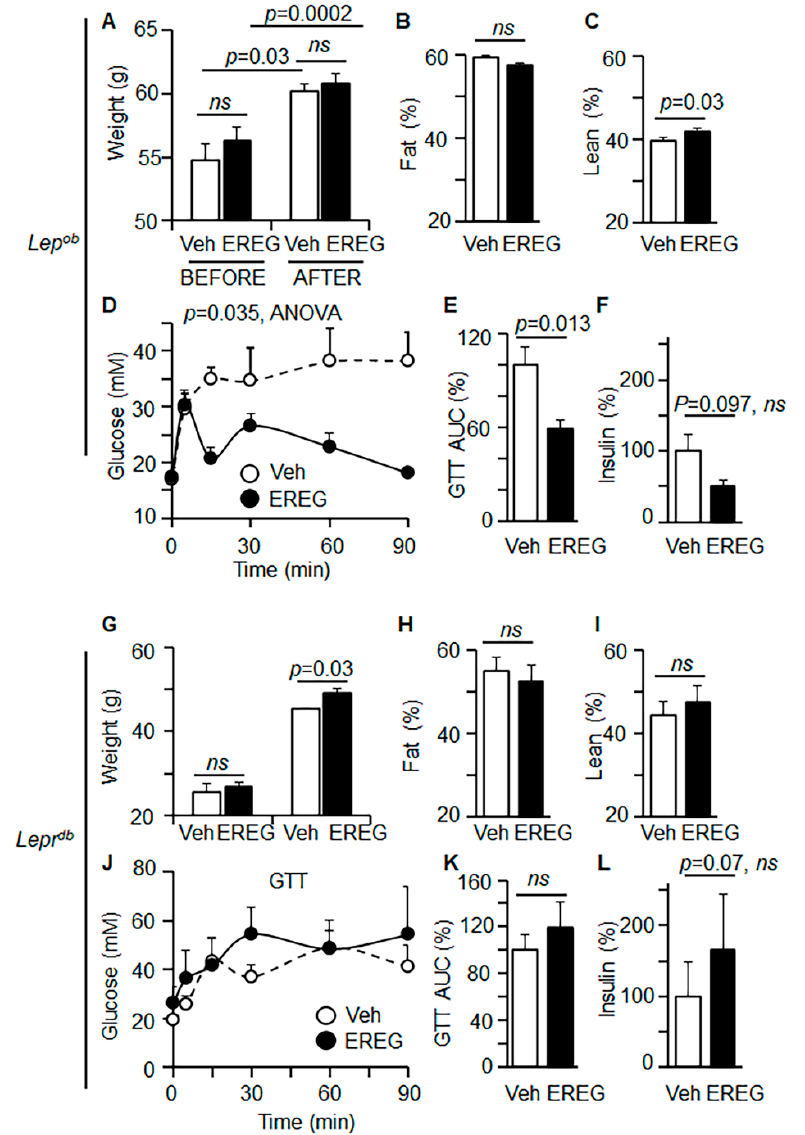
Figure 1. EREG improved glucose tolerance in the absence of leptin in Lep ob mice and exhibited no effect in LepR ‐ deficient Lepr db mice. ( A ) Body weight of Lep ob male mice in groups before and after treatment with Veh (PBS, white bar) or EREG (50 ng/g body weight (BW), black bar) for 26 days. Mice were on regular chow diet. Unpaired t ‐ test, n = 7/group. ns, not significant. ( B , C ) Fat ( B ) and lean body ( C ) composition in same groups of mice at the end of the study was measured by Echo ‐ MRI. Fat and lean mass are shown as % of the total weight (100%). ( D , E ) Glucose tolerance test (GTT) was performed in fasted Lep ob mice treated with PBS (Veh, open circles) or EREG (closed circles) ( n = 7 per group). GTT kinetics ( D ) and area under the curve (AUC) ( E ) are shown. Statistical significance was examined by ANOVA ( D ) and Student’s t ‐ test ( E ). ( F ) Insulin levels in plasma in both mouse groups were measured by ELISA. Unpaired student’s t ‐ test. ( G ) Weight before and after treatment of Lepr db male mice with Veh (PBS, white bar) or EREG (50 ng/g body weight (BW), black bar) for 4 weeks ( n = 6 per treatment). Mice were on regular chow. Unpaired Student’s t ‐ test, n = 6/group. ( H , I ) Fat ( H ) and lean body ( I ) composition (% of total weight) in the same groups of mice at the end of the study were measured by Echo ‐ MRI. ( J , K ) GTT kinetics ( J ) and AUC ( K ) were obtained from Lepr db mice treated with PBS (Veh, open circles) or EREG (closed circles). ANOVA ( J ) and Student’s t ‐ test ( K ). ( L ) Insulin levels in plasma in both mouse groups were measured by ELISA. Unpaired student’s t ‐ test.